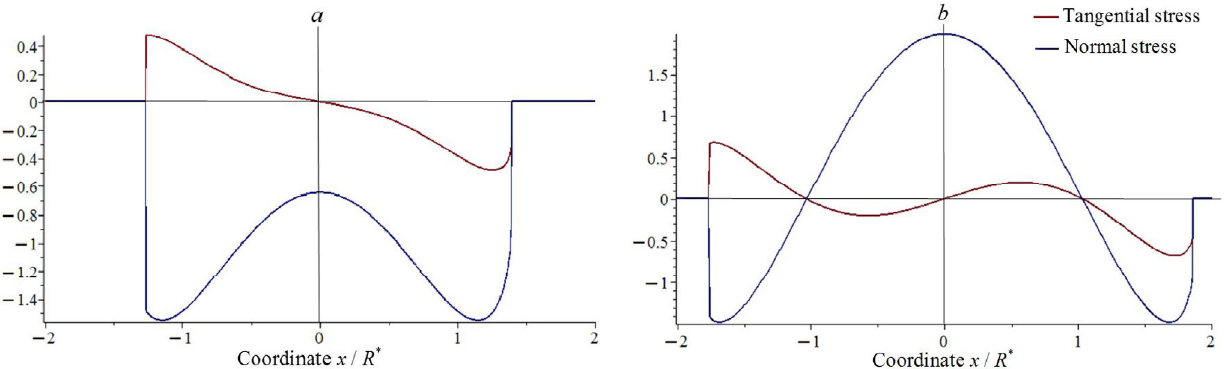
Fig. 5 Normal and tangential forces between two asperities in the sliding of two rough